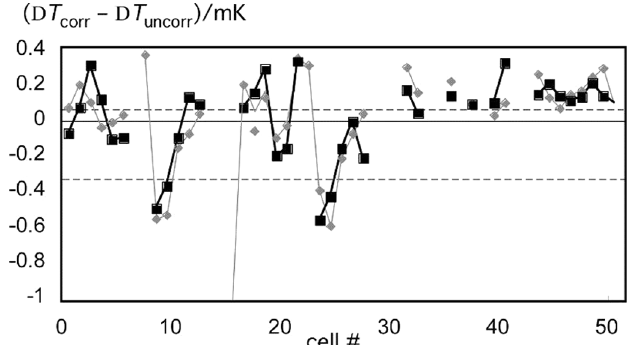
Fig. 4. Graphical representation of differences from the KCRV of K2-xx and Star direct-cell Inter-comparison, uncorrected (gray dots and lines) and corrected (black squares and lines): ( T – KCRV K2ac )=D T thermal,ac (Tab. 2); ( T – KCRV K2bc ) = D T original (Fig. 1). On the left until #28 : K2-xx differences for cells #1 to #15 and thermometer sets #1 and #2. D T original,#1 = – 147(268) m K, D T original,#2 = – 166(309) m K; D T thermal,ac,#1 = – 167 (233) m K, D T thermal,ac,#2 = – 147(240) m K. On the right from #30 to end : Star differences (56(68) m K; 74(87) m K before